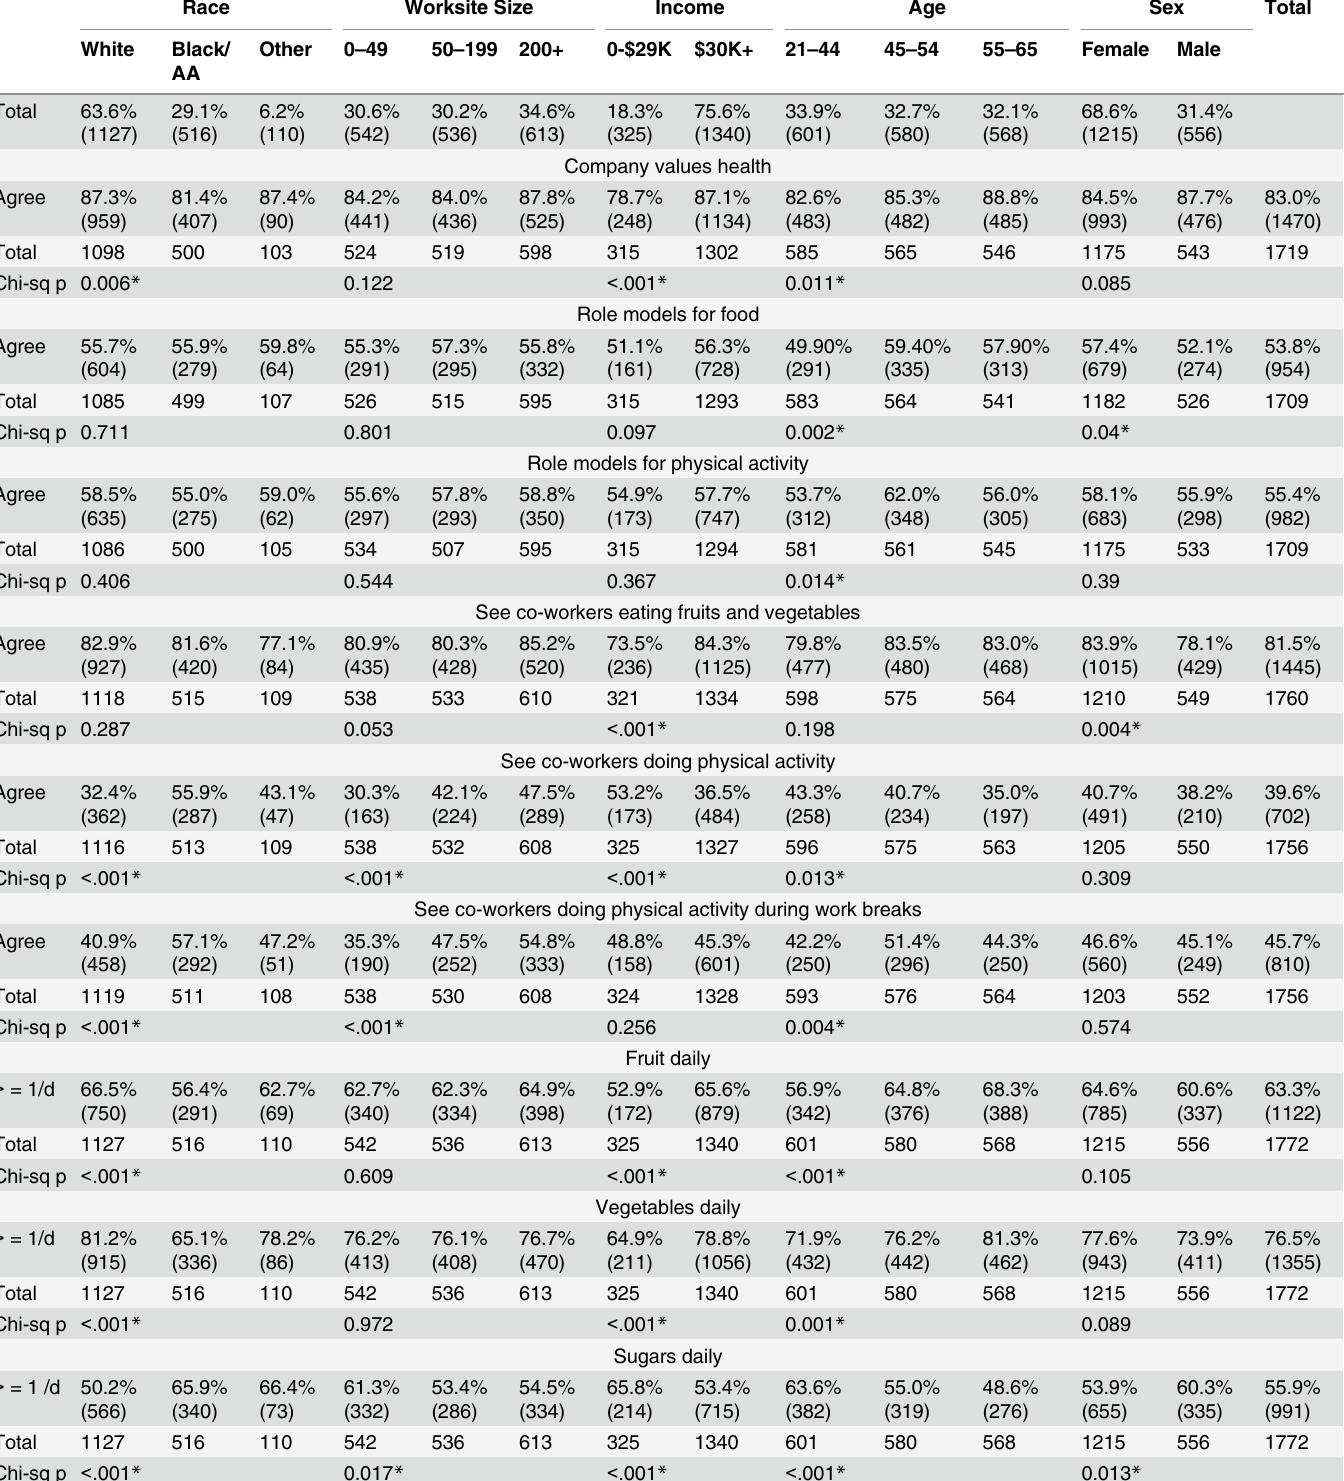
Table 1. Social/Organizational, Diet, physical activity, and Obesity variables and demographics % † (n), Missouri, USA n =